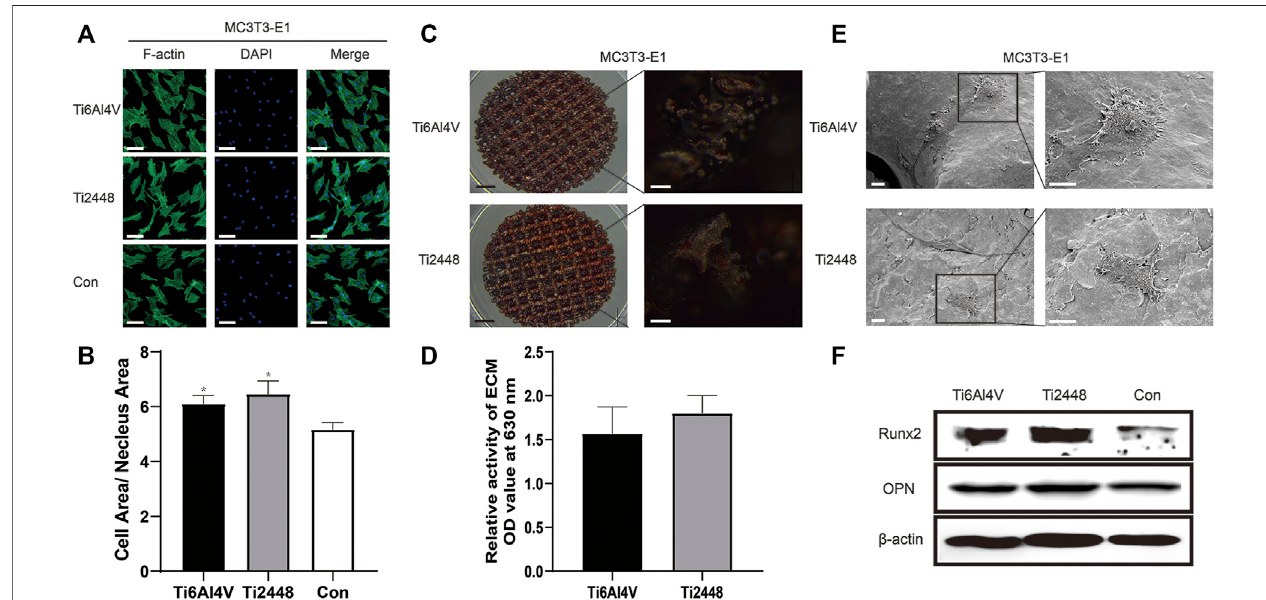
FIGURE 8 | Evaluation of the effects of different scaffolds on osteogenesis in MC3T3-E1 cells in vitro . Staining of the cytoskeleton in MC3T3-E1 cells. Scale bar (cid:2) 100 µm (A) . Quantitative analysis of the cell area/nuclear area in different groups (B) . Alizarin red staining after 21 days of osteogenic induction to evaluate the effect of different scaffolds on MC3T3-E1 cells. Scale bars: black (cid:2) 2 mm, white (cid:2) 100 µm (C) . Semiquantitative analysis of mineralization in cells cultured on different scaffolds (D) . Observation of the cell morphology on the surface of the scaffolds by SEM. Scale bar (cid:2) 100 µm (E) . Analysis of the expression levels of Runx2 and OPN by western blot (F) . Note: * p ＜ 0.05 compared to the